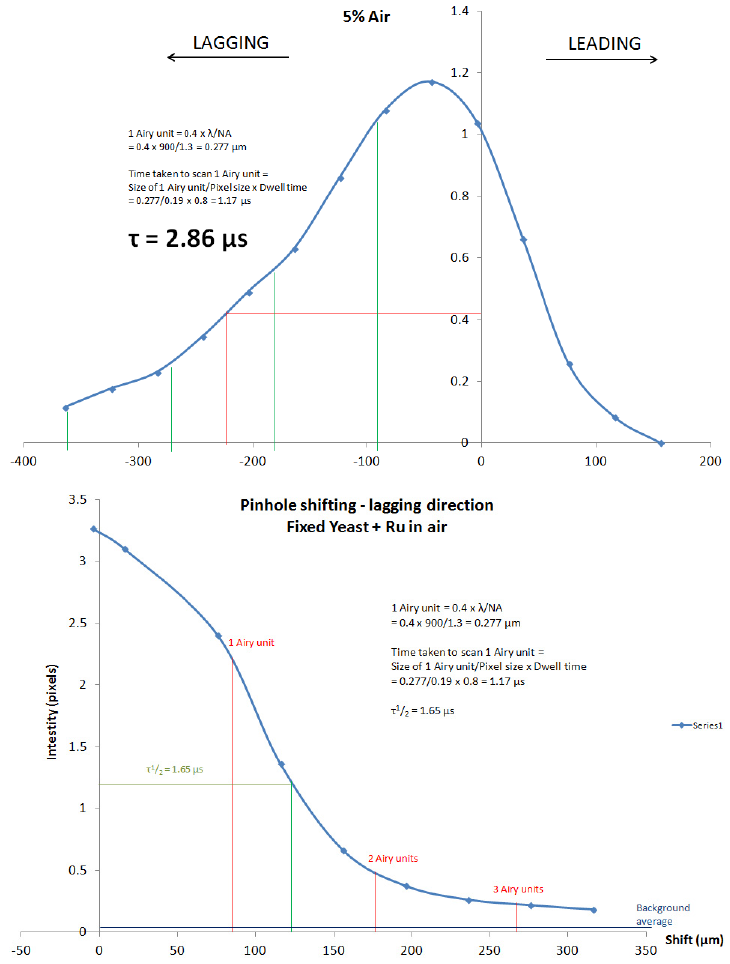
Fig. 2. Two examples of calculations of phosphorescence lifetime measurements from experiments with Ru nanoparticles in suspension or after electroporation into ethanol-¯xed Schizosaccharomyces pombe that used the pinhole shifting method of Ram- shesh and Lemasters. 51